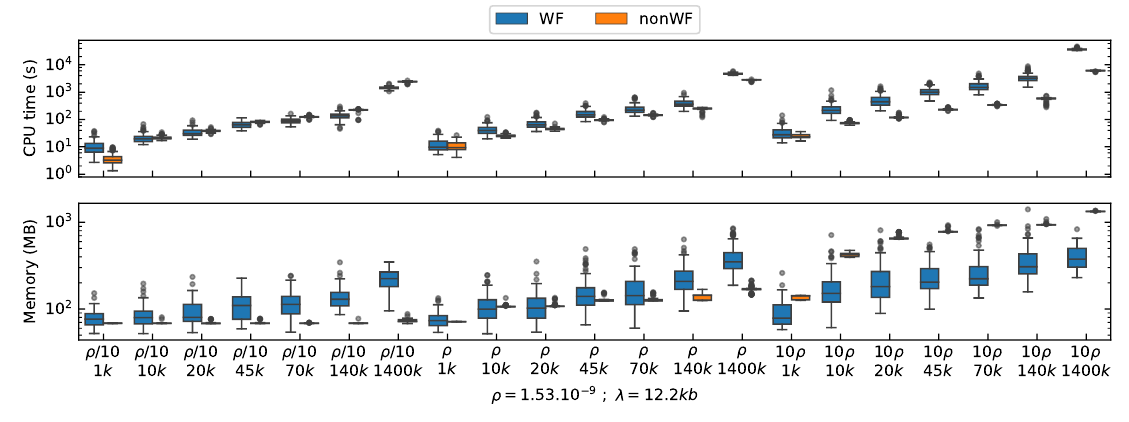
Figure S4 – Computing time for different numbers of forward-simulated generations, with three different recombination rates. Ne =140 000, λ = 12200 bp and RF=25.